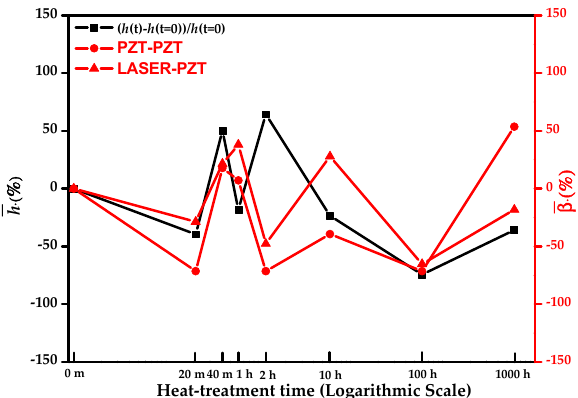
Figure 8. Relative variations of parameter of hysteretic nonlinearity for longitudinal acoustic waves, h ≡ [ h ( t ) − h ( t = 0 )] / h ( t = 0 ) , and of parameter of elastic quadratic nonlinearity for the Rayleigh-type surface acoustic wave, 𝛽̅ ≡ (cid:3435)𝛽 (cid:2911)(cid:2917)(cid:2915)(cid:2914) − 𝛽 (cid:2919)(cid:2924)(cid:2930)(cid:2911)(cid:2913)(cid:2930) (cid:3439) 𝛽 (cid:2919)(cid:2924)(cid:2930)(cid:2911)(cid:2913)(cid:2930) ⁄ (adopted from Reference [56]).